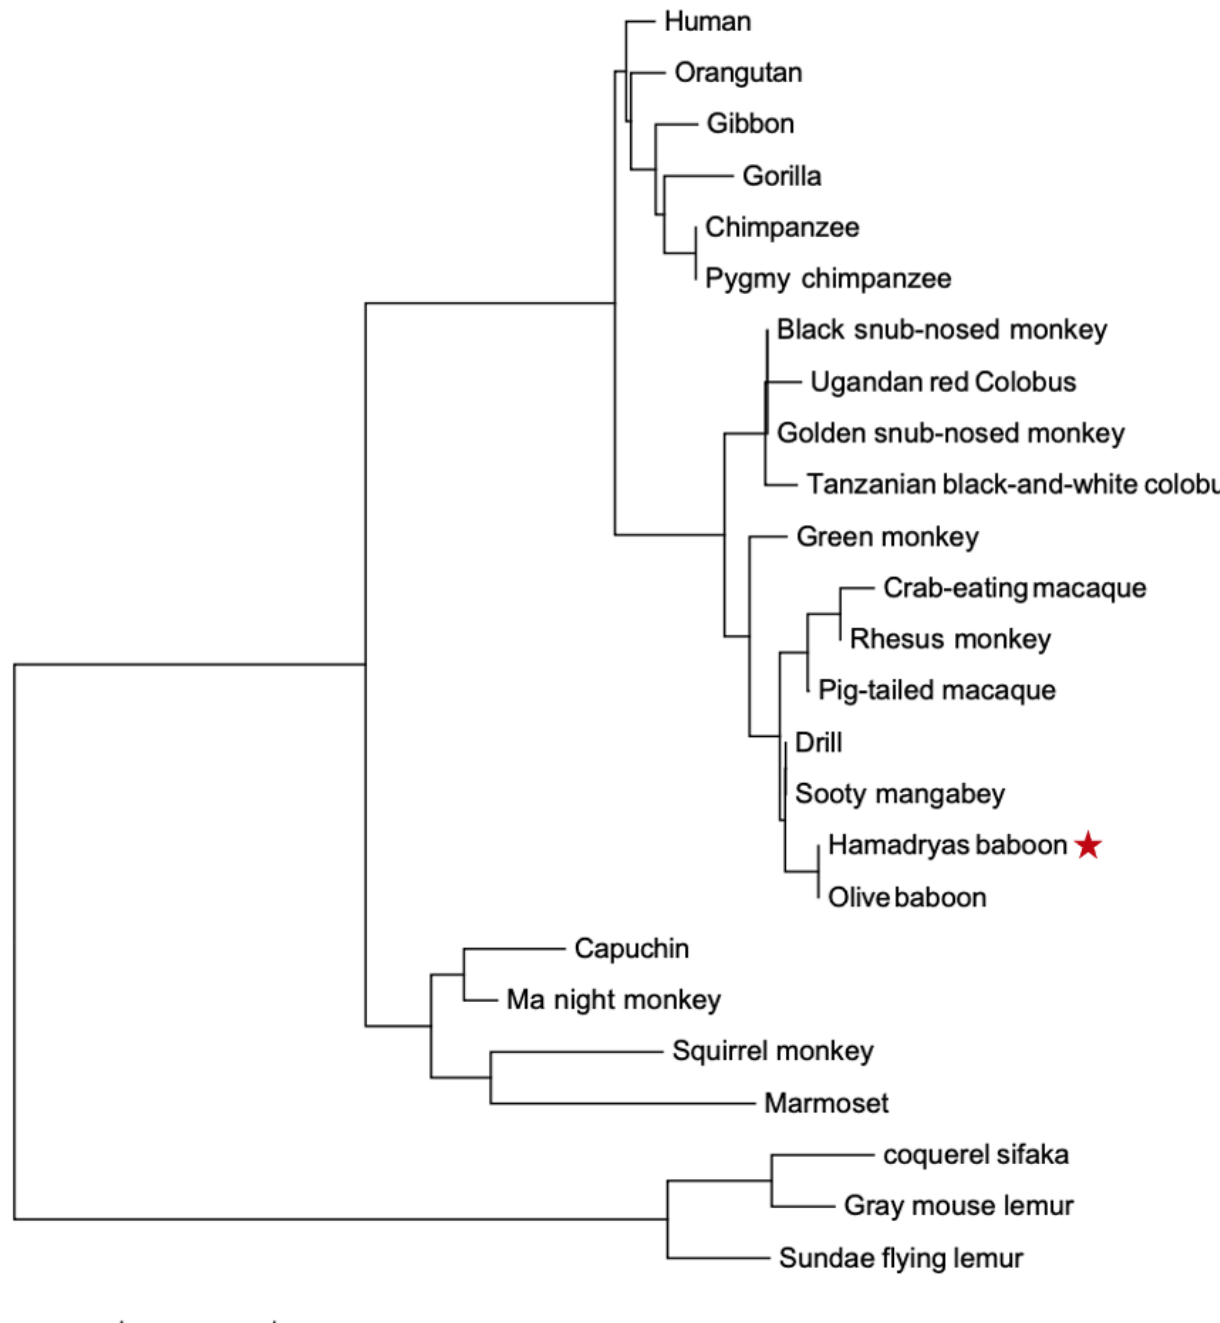
Figure 5. Phylogenetic tree of PRL proteins from various primates. Clades are specific in linage, apes, OWM, NWM, lemur, and out-group. The tree was built using MEGA version 6.06 by the NJ method and further bootstrap analysis of 1000 replicas. The red star corrrespon to the sequence we found.